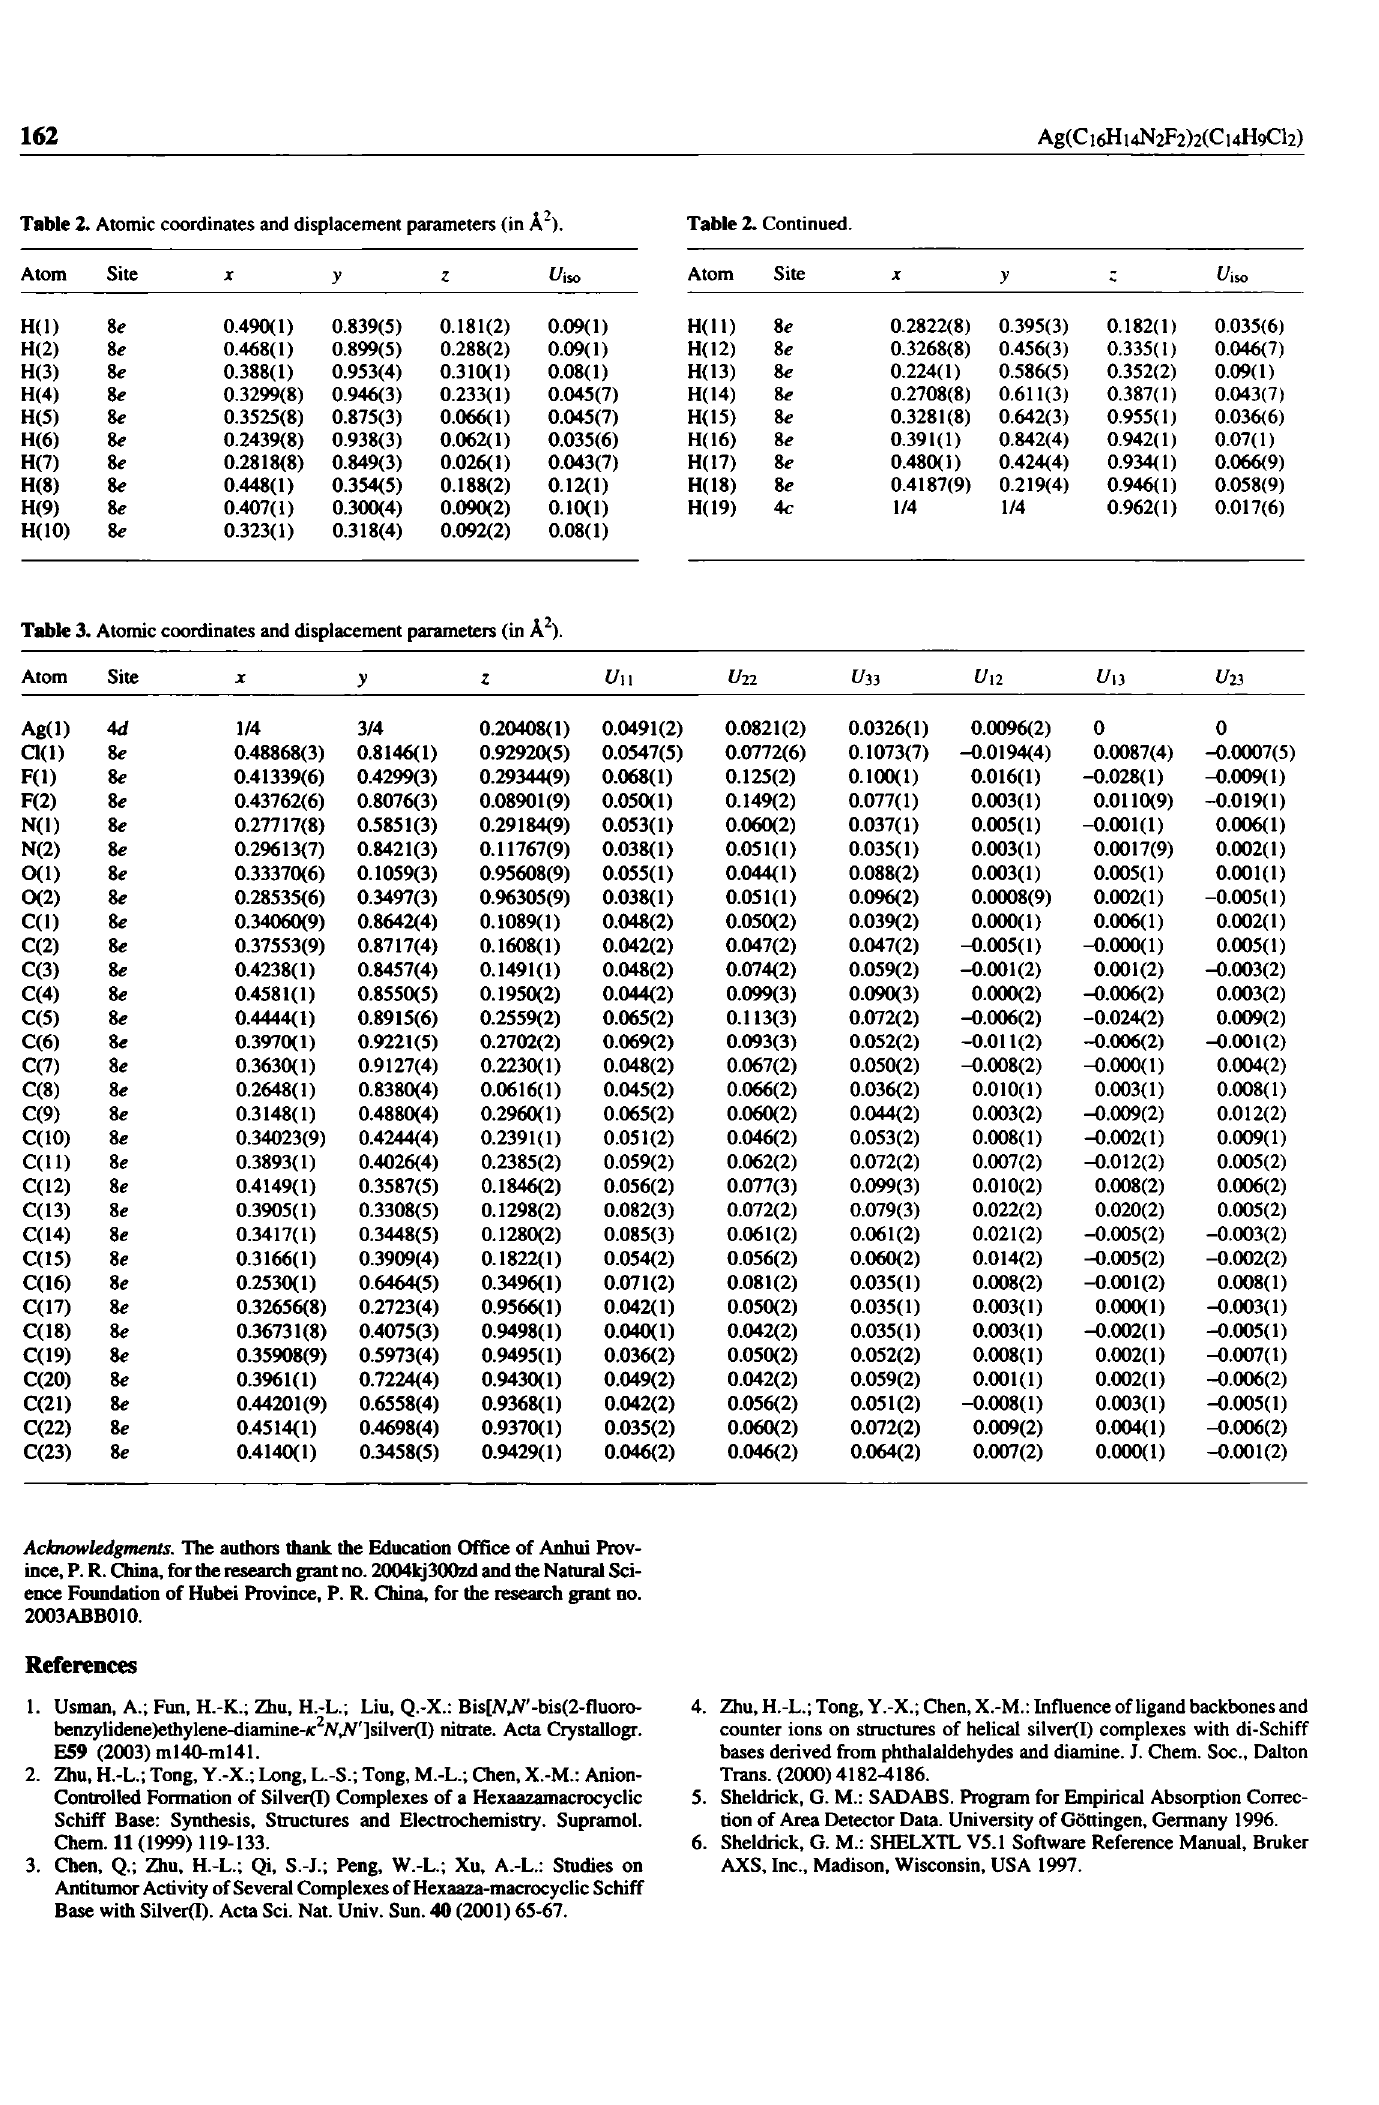
Table 3. Atomic coordinates and displacement parameters (in Â 2